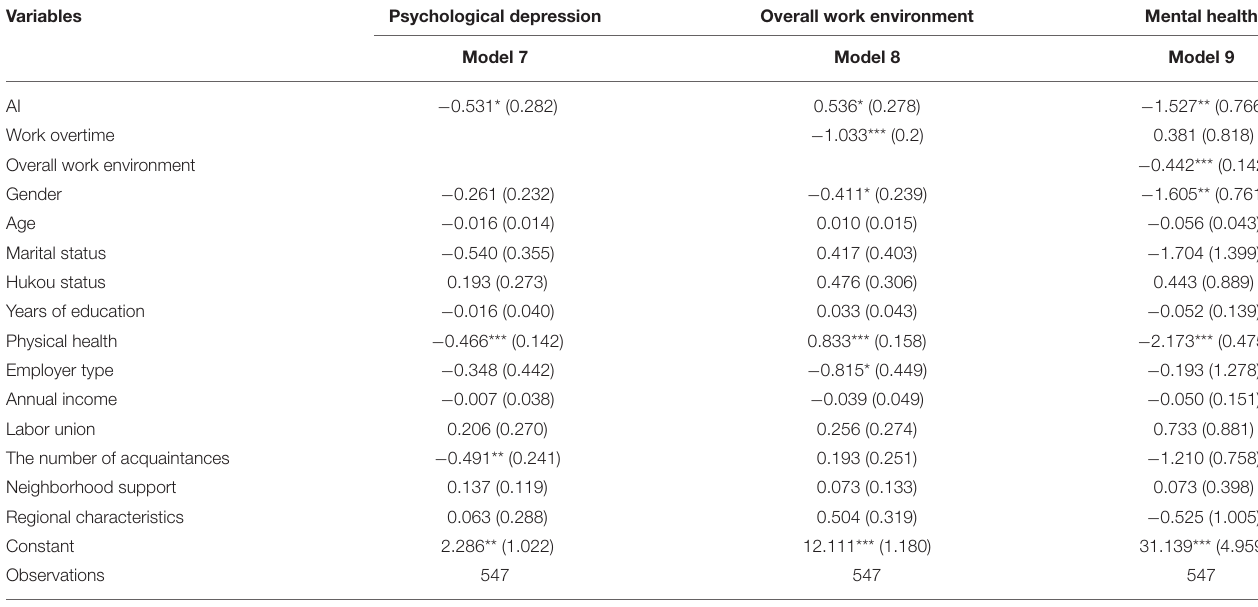
TABLE 4 | The impact of AI on the mental health of manufacturing workers: a robustness tests.